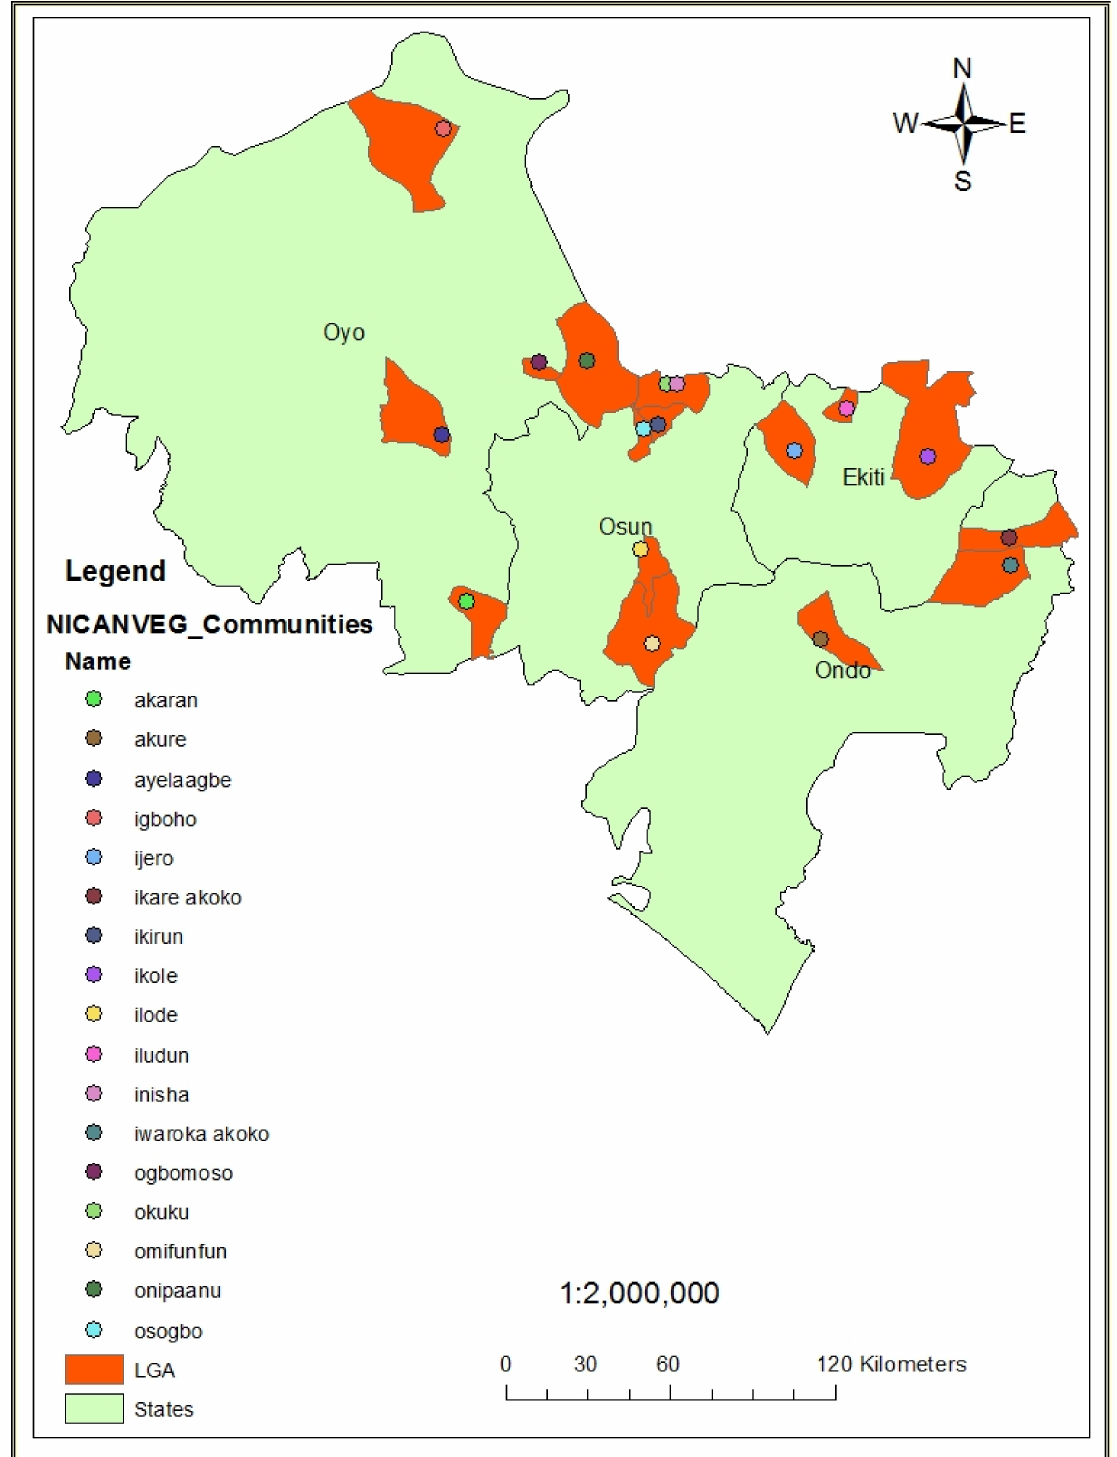
Figure 1. Map of the study